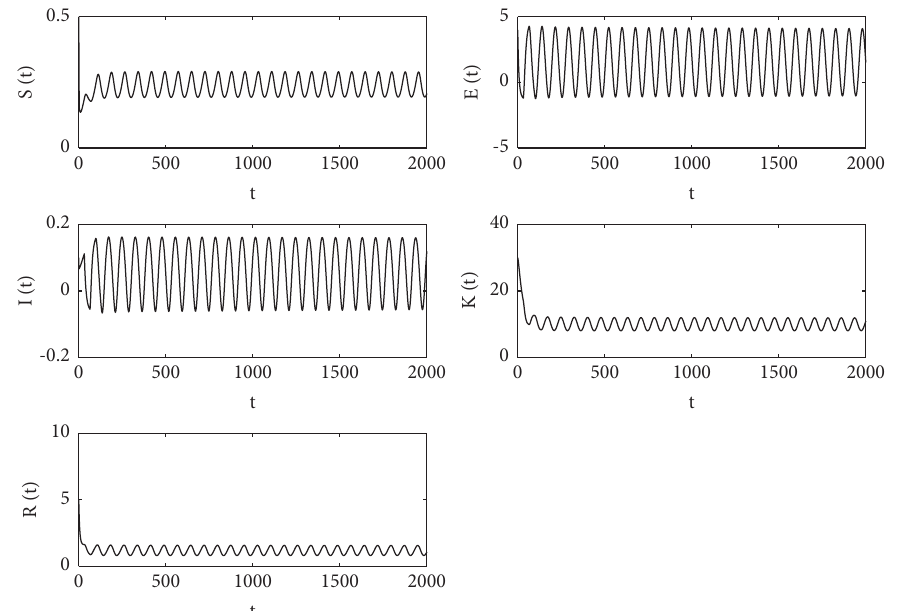
Figure 4: Phase portrait of fractional system (4). When τ asymptotically